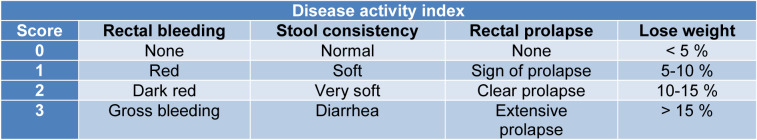
The disease activity index scoring parameters